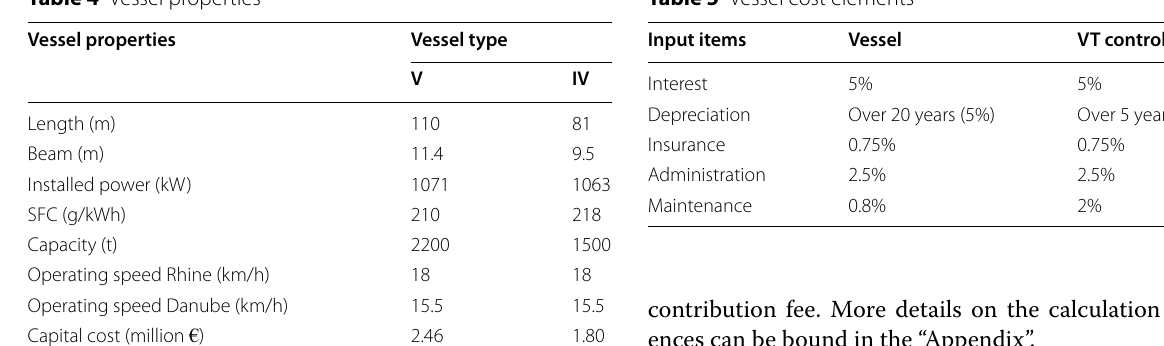
Table 4 Vessel properties Table 5 Vessel cost